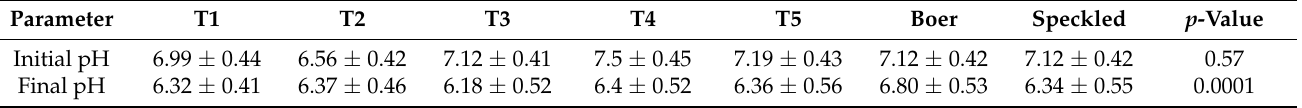
Table 2. Effect of breed and treatment on ruminal pH of goat (Adopted from Maake et al., 2021 [10]). Parameter